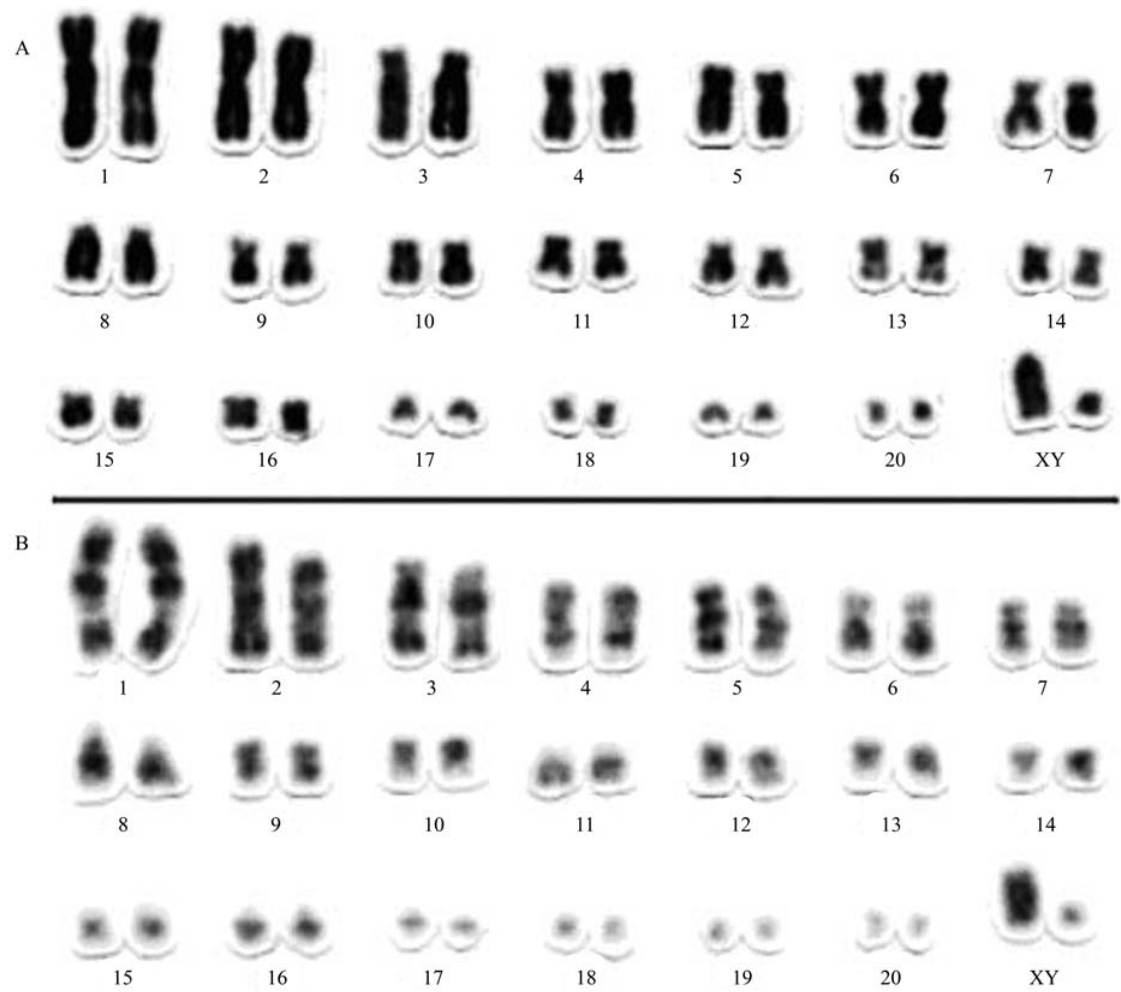
Figure 1 - Karyotype of a male Callistomys pictus with 2n = 42 and FN = 76 after: (A) Conventional staining and (B) GTG-banding.